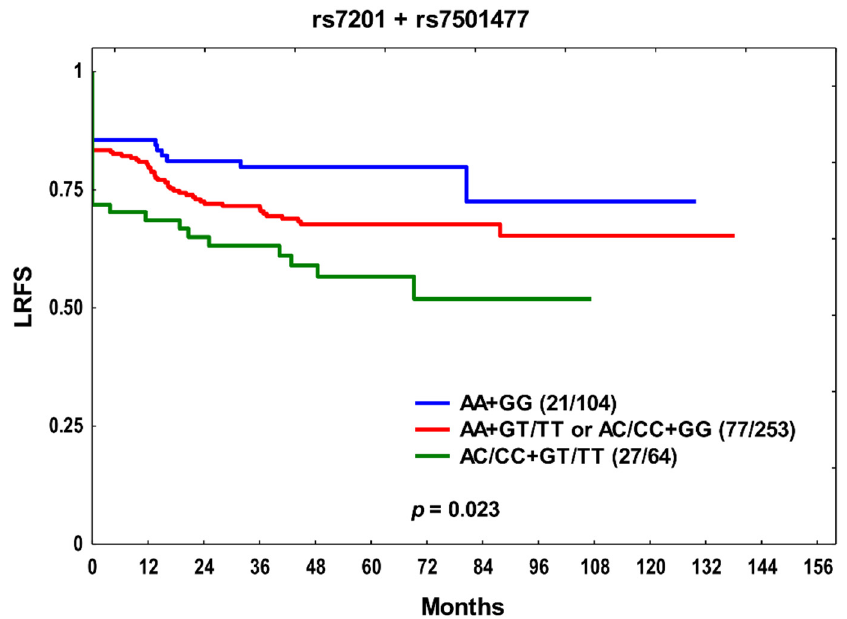
Figure 2. The Kaplan–Meier plot showing combined effects of MMP2 rs7201 and TIMP2 rs7501477 on locoregional recurrence-free survival (LRFS) in the studied group. Number of events and n are shown in the brackets.